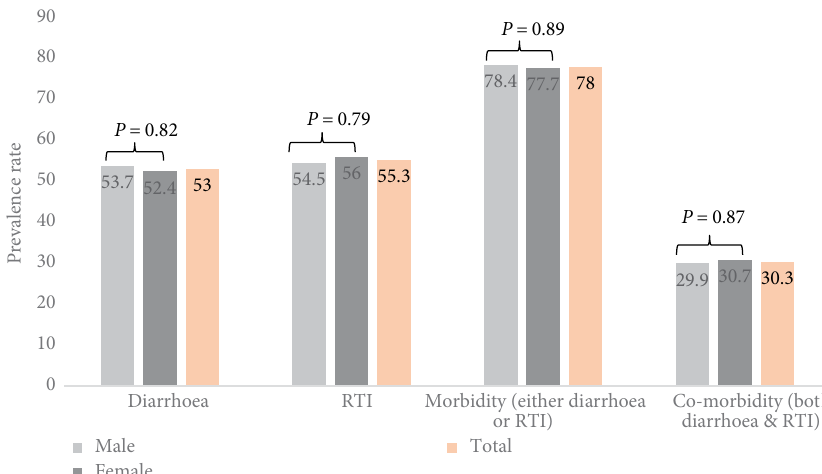
Figure 1: Prevalence of diarrhoea and respiratory tract infections (RTIs) among the 6–23 months old children 2 weeks prior to the